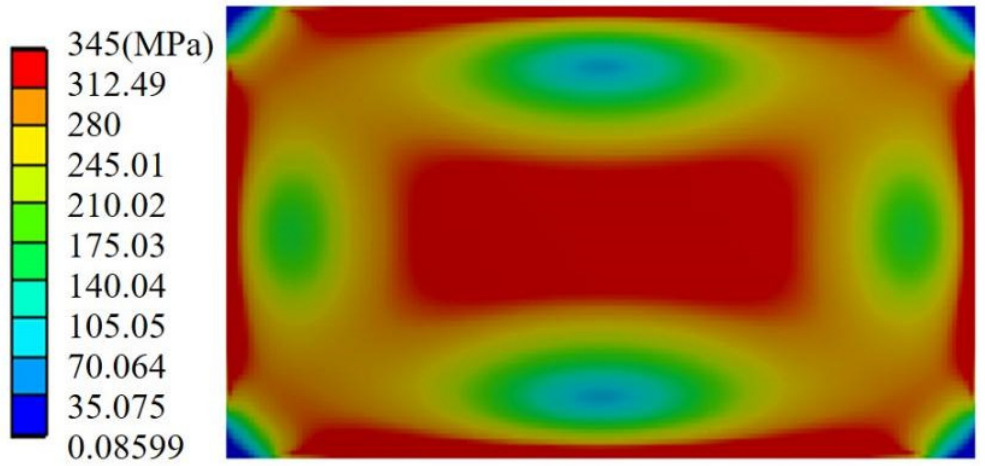
Table 1. Comparison of reinforcement effects for the ribs on a plate.